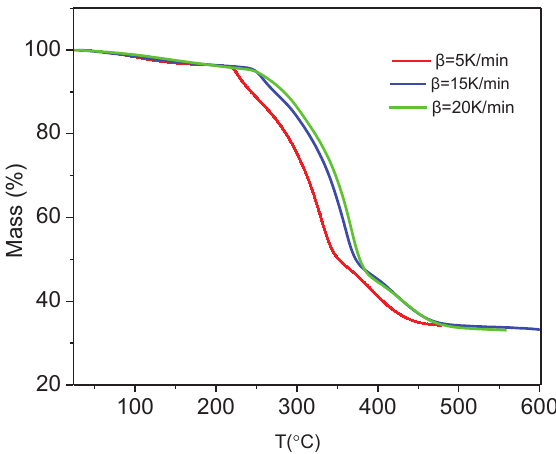
Figure 2: Thermogravimetric analysis (TGA) curve of NPL-1.